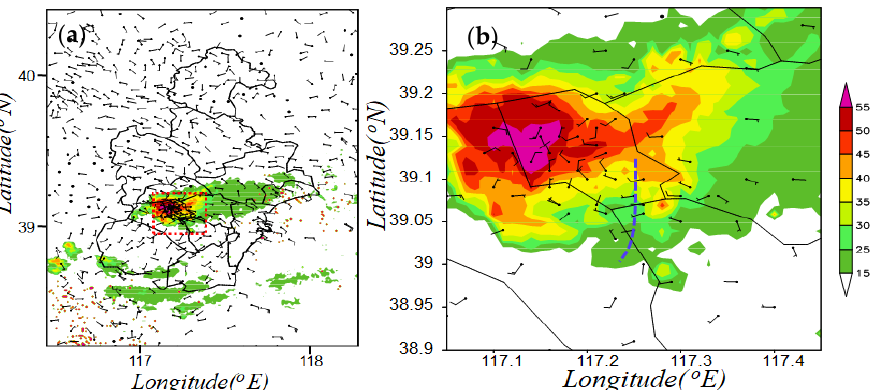
Figure 8. ( a ) Composite reflectivity (colored, unit: dBZ) and surface wind (vector, unit: m·s − 1 ) at 19:00 BT on 1 August 2019. ( b ) Enlarged view of the red dashed box in Figure 9a, and the blue dashed line is the gust front.